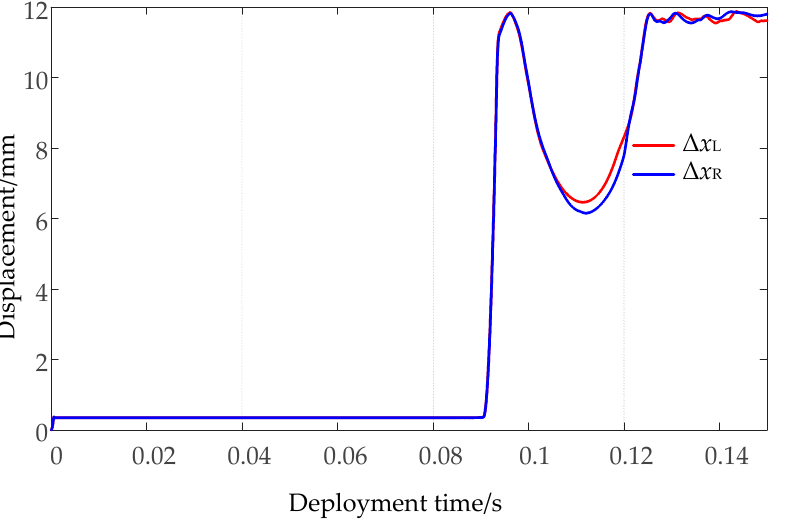
Figure 8. The relationships between the displacement of locking springs and deployment time. The results show that, after triggering the longitudinal locking mechanism, the locking pins are released by the prestressing force of the locking springs and collide with the locking holes. The rebound movement of the locking pin causes the sudden change in its speed. However, under the action of the force of locking spring, the locking pin moves downwards and collides with the inner wing again and again, until the speed drops to zero. The movement of the springs and locking pins on both sides are basically the same.